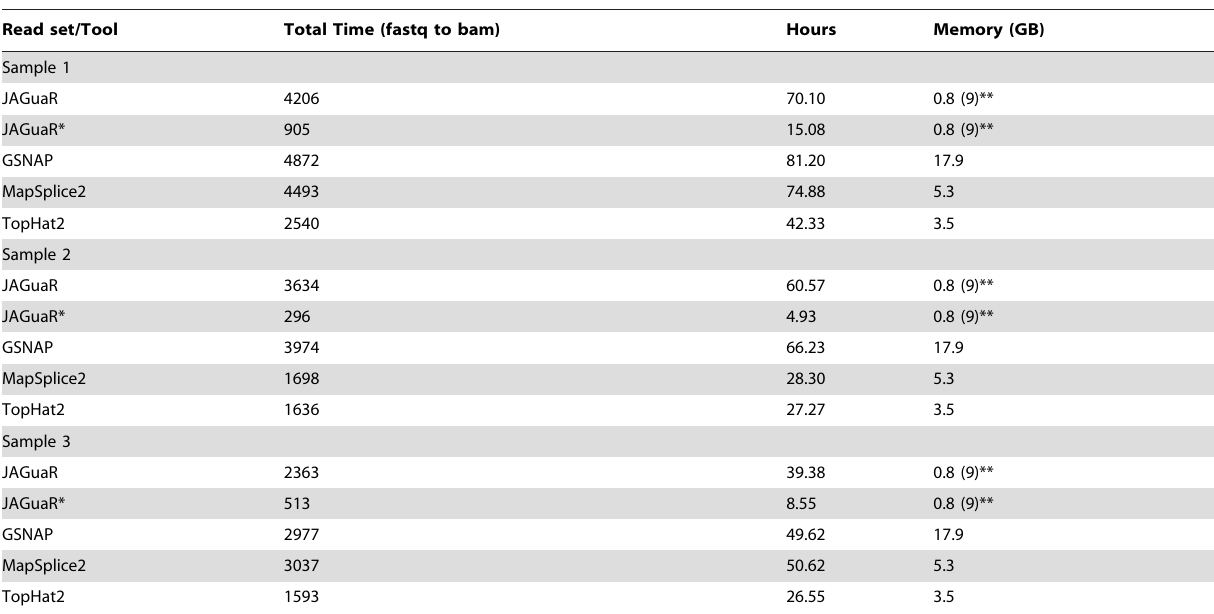
Table 2. Execution Time.